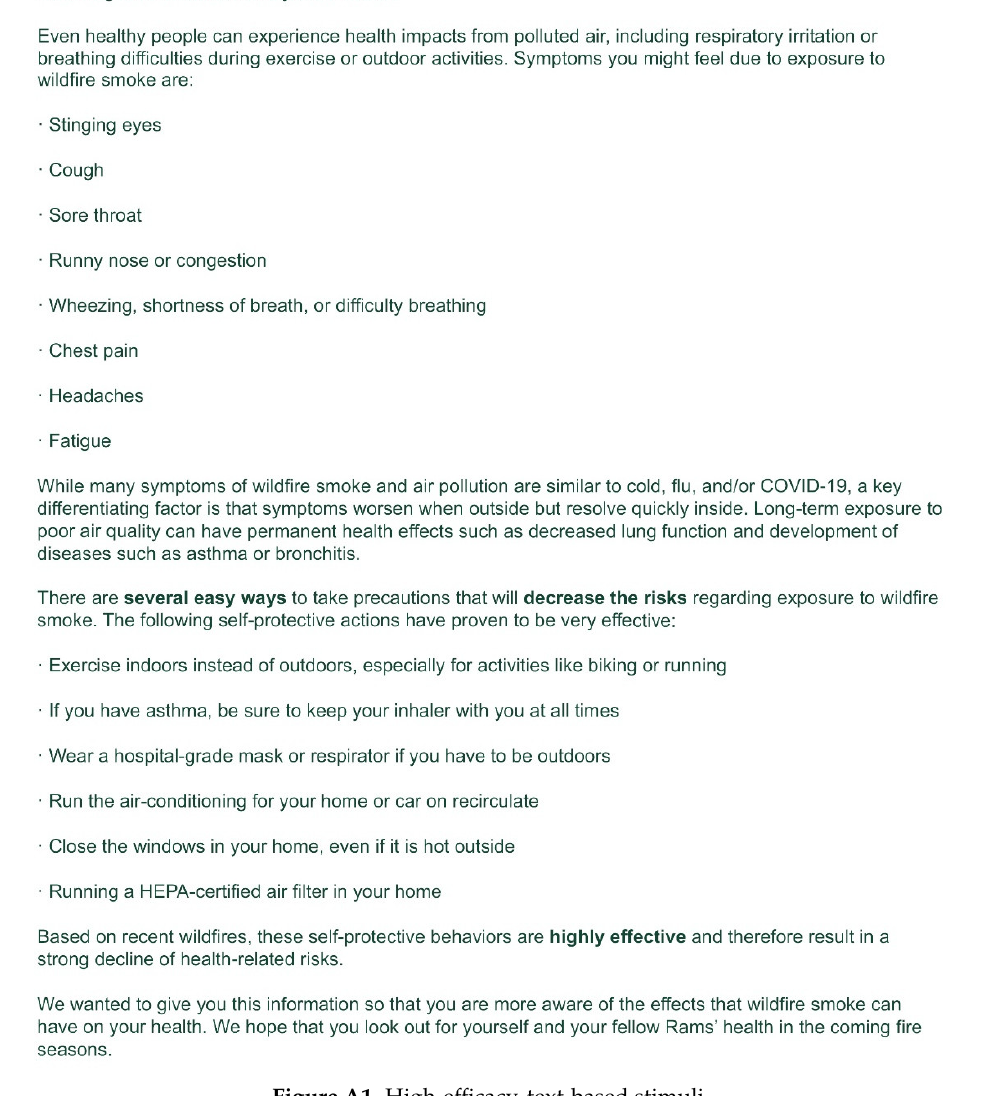
Figure A1. High-efficacy, text-based stimuli.